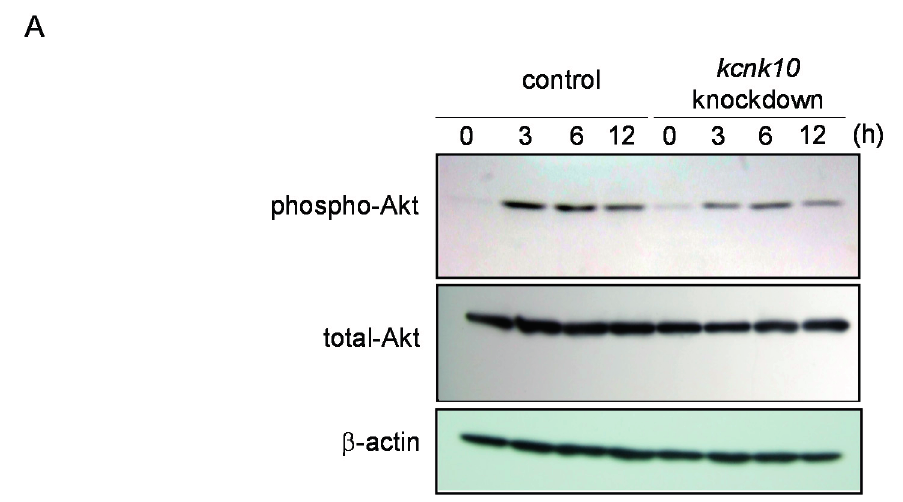
Figure 4. Effect of kcnk10 knockdown on Akt phosphorylation. At 72 h after transfection, post-confluent kcnk10 knockdown cells or control cells were induced to differentiate into adipocytes. Whole-cell lysates were prepared at various time points after induction and were subjected to Western blot analyses. ( A ) These figures show typical results; ( B ) Quantitation of reduction rate of phospho-Akt after induction; and ( C ) Quantitation of reduction rate of total-Akt after induction. The asterisks indicate significant differences compared with the values for control cells ( * p < 0.01, ** p < 0.05). All immunoblots obtained from 3 different lots were shown in Supplementary Figures